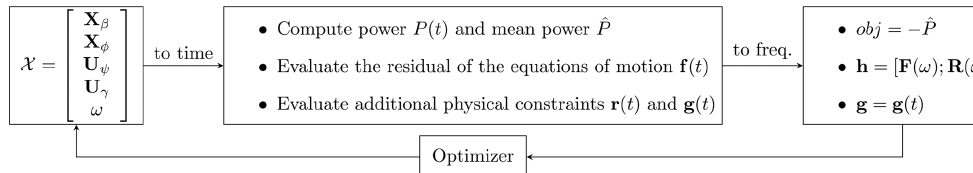
Figure 2. Graphical representation of the optimal control problem setup.